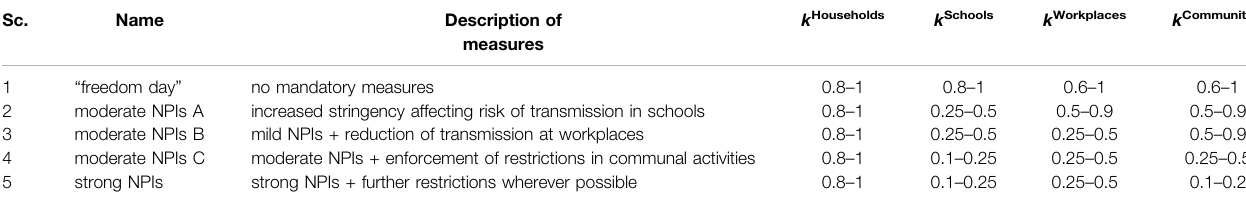
TABLE 1 | Different scenarios of mandatory NPIs. Listed are descriptions of the general measures imposed in each scenario as well as the input parameters to the function k ] NPI , self ( H R ) thatmodulatesthespread.Theparametersactasmultiplicativefactorsontoinfectiontermsinourmodel,thushighparametervalues(closeto1)translateto little reduction in infections and lowparameters (close to0) translate tostrong reductionsin infections. For each cell, the fi rstparametertranslates toareductionat high ICUs ( k ] ( H (cid:2) H )) and the second parameter to the corresponding reduction at empty ICUs ( k ] R max NPI , self Figure S3 ).